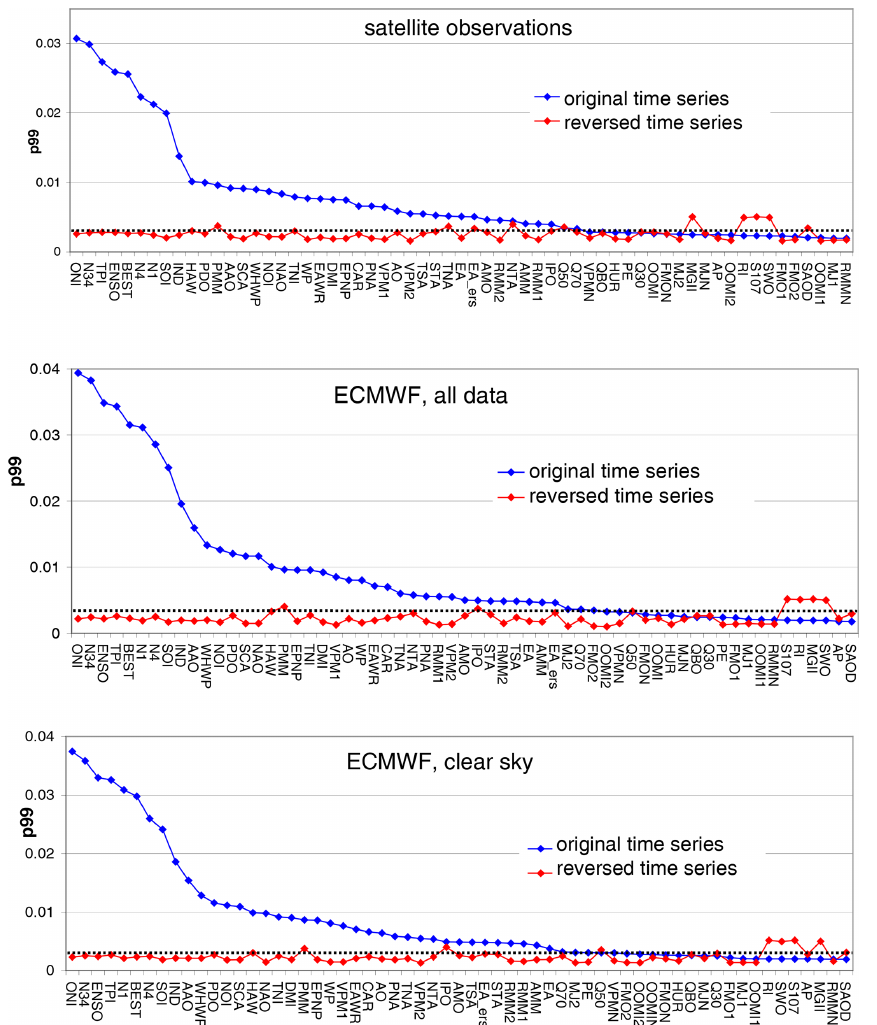
Figure 7. Blue markers: 99th percentiles (p99) of the delta rms of the original indices for the three TCWV data sets. Red markers: similar results for the temporally reversed indices. Black lines: significance threshold. The indices are sorted from highest to lowest p99 values for the original indices. Note that different y axes are used for the satellite and model